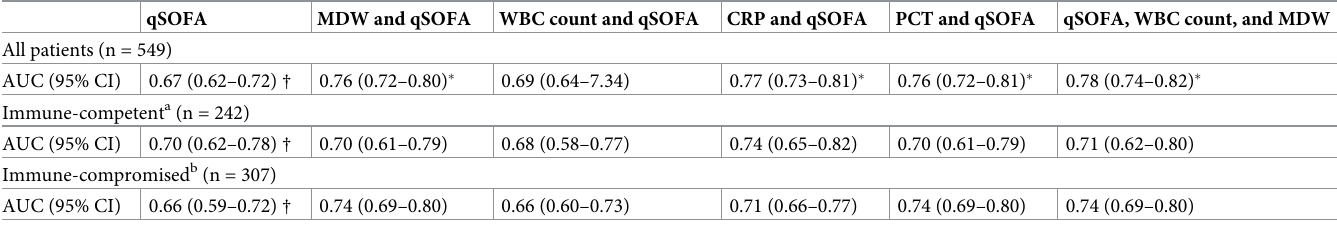
Table 5. Comparison of discriminative performance of biomarkers combined with